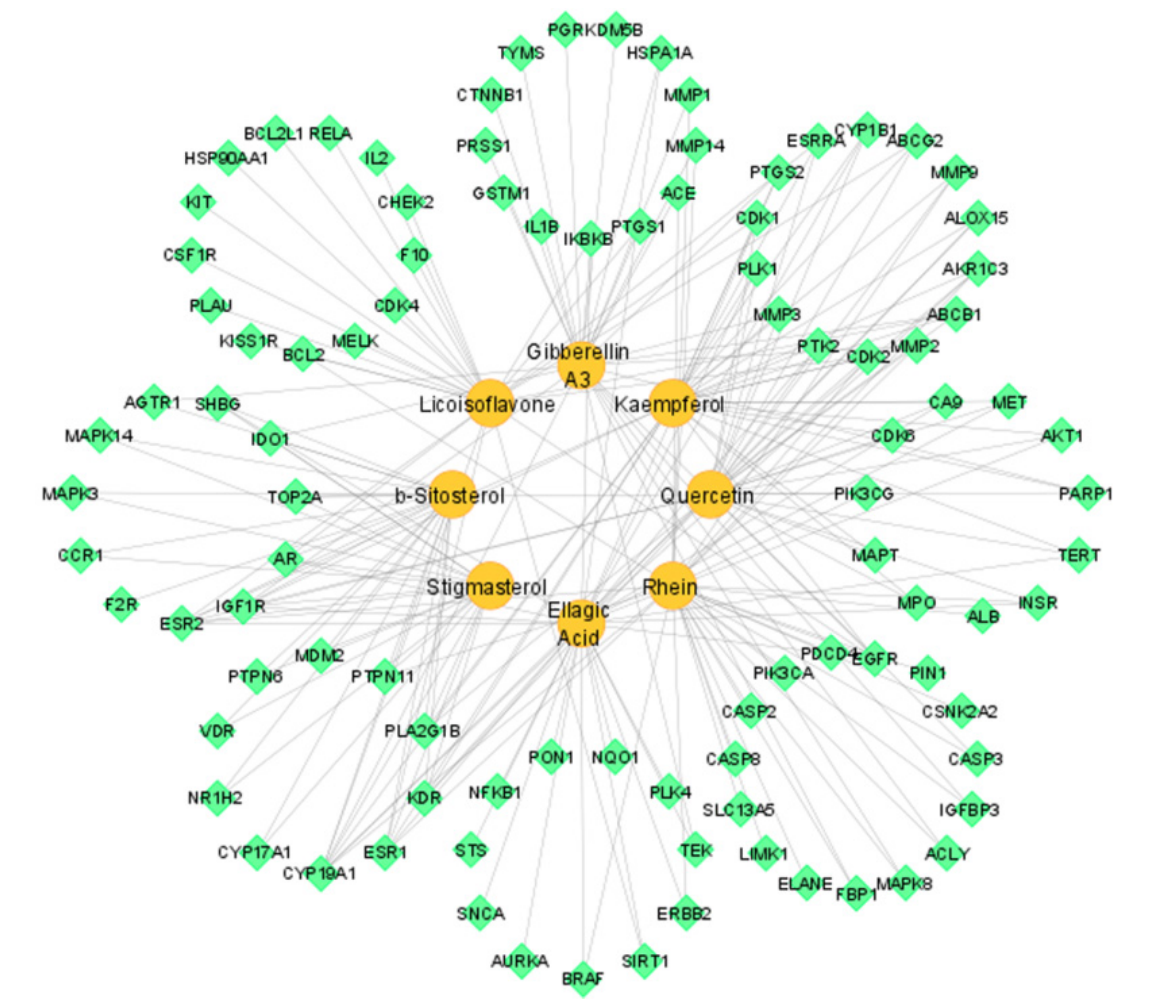
Figure 3. Compound–target network of active constituents and potential targets (circle shape shows active constituents and diamond shape shows potential targets).